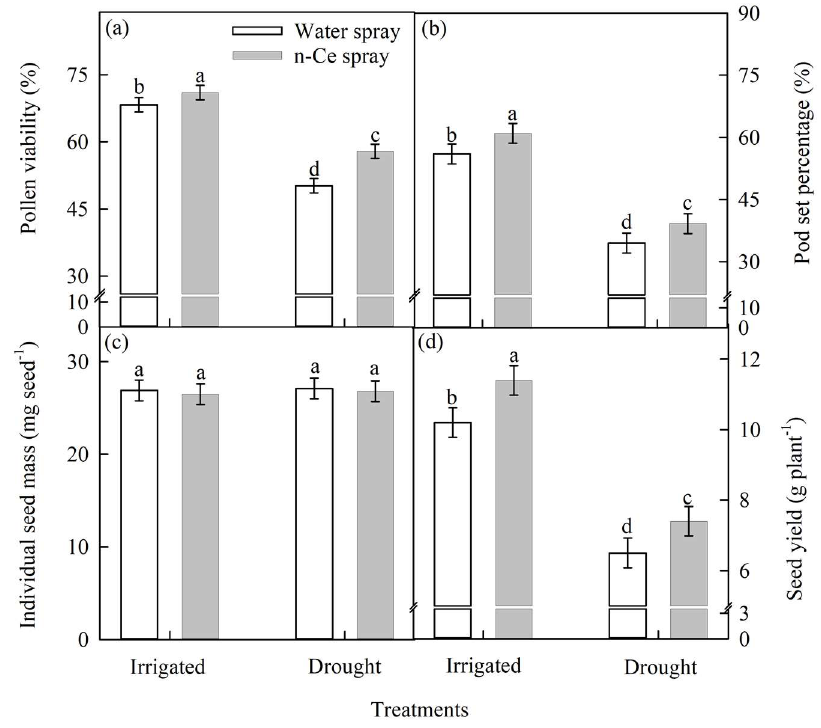
Figure 8. Effect of drought and foliar spray of nanoceria on ( a ) pollen viability (%), ( b ) pod-set percentage (%), ( c ) individual seed weight (mg seed − 1 ), and ( d ) seed yield (g plant − 1 ) in mungbean (pot culture experiment). Each value is the mean ± SD of 5 independent measurements. Means with different letters are significantly different at p ≤